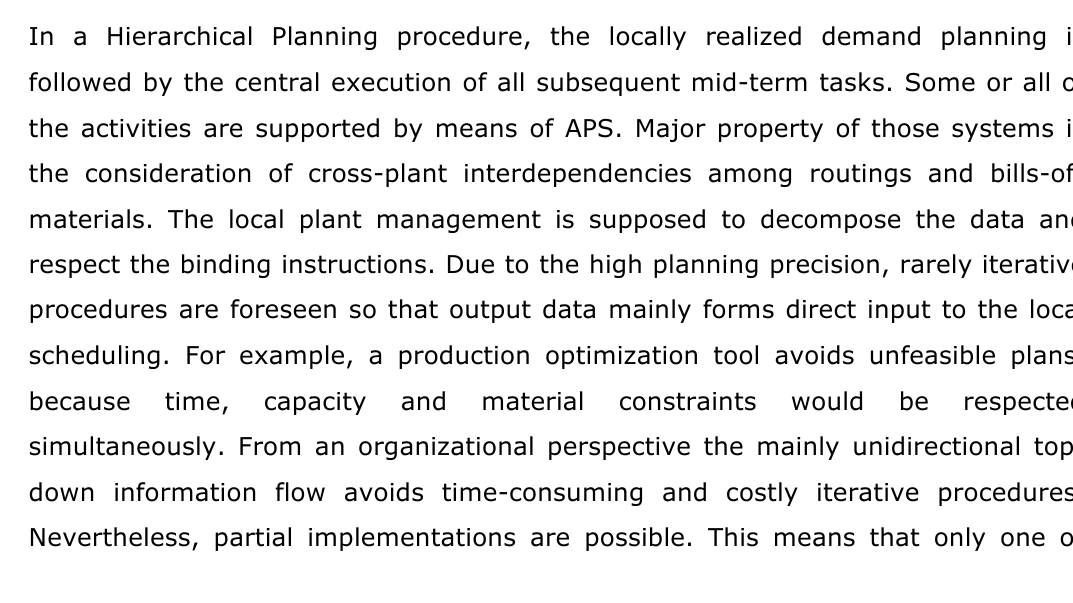
Figure 2. “Local and central planning under a process plant